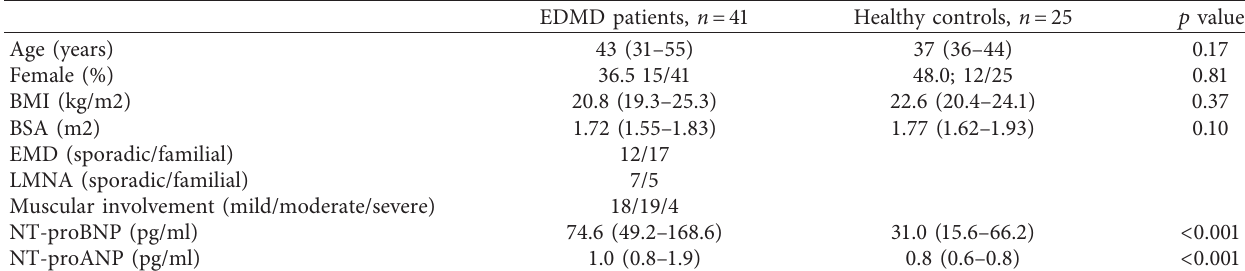
Table 1: Baseline characteristics of the study population.